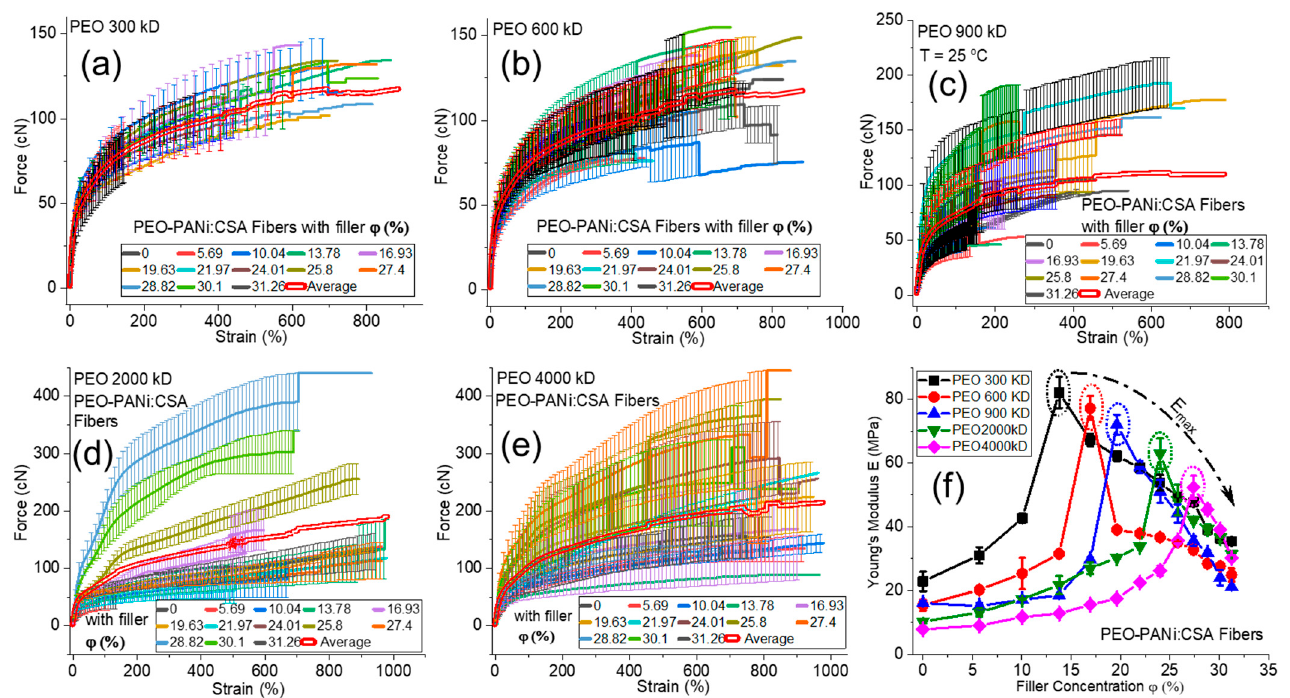
Figure 7. Panels ( a – e ) show the force-strain curves for PEO-PANi:CSA fibers using 300 kD–4000 kD molar mass of PEO. The percentage volume fraction ( φ % ) of PANi varies from 0–31% for each molar mass of PEO. The bold double red lines ( a – e ) represent the average of all force-strain curves. Panel ( f ) shows elastic Young’s modulus ( E ) as a function of percentage volume fraction ( φ % ) of PANi for PEO-PANi:CSA fibers at each molar mass of PEO (300 kD–4000 kD). The dotted circles ( f ) represent the maximum elastic Young’s modulus ( E max ) for each molar mass. Figure 8a–c show the force-strain curves for PEO (900 kD)-PANi:CSA fibers using 50–70 °C annealing temperature for 0–31 φ % of PANi, respectively. Figure 8d shows the